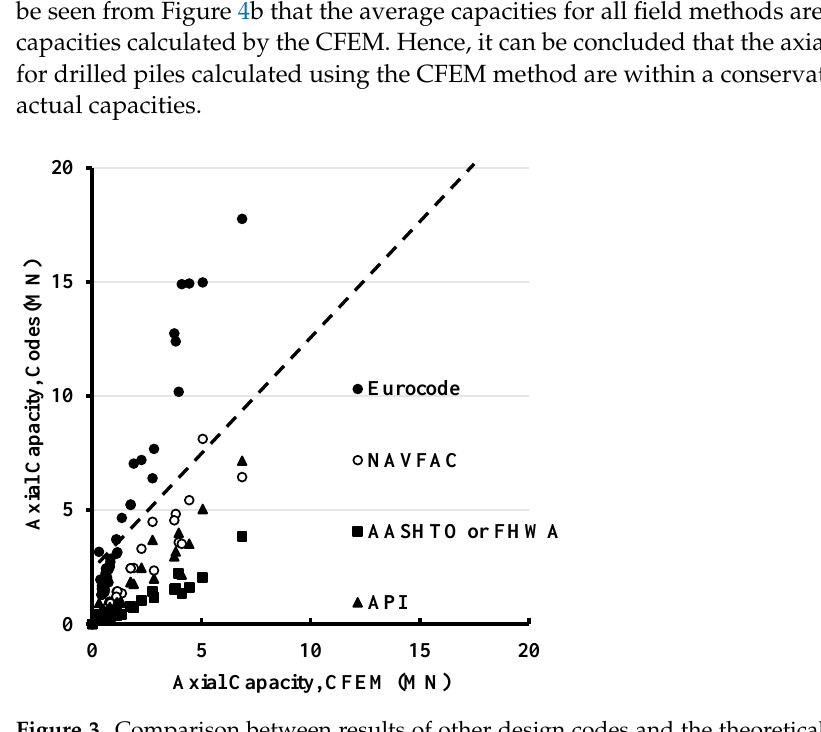
Figure 2. Comparison between the theoretical axial capacity in driven piles determined using the CFEM method and ( a ) the field results, and ( b ) the average field results.